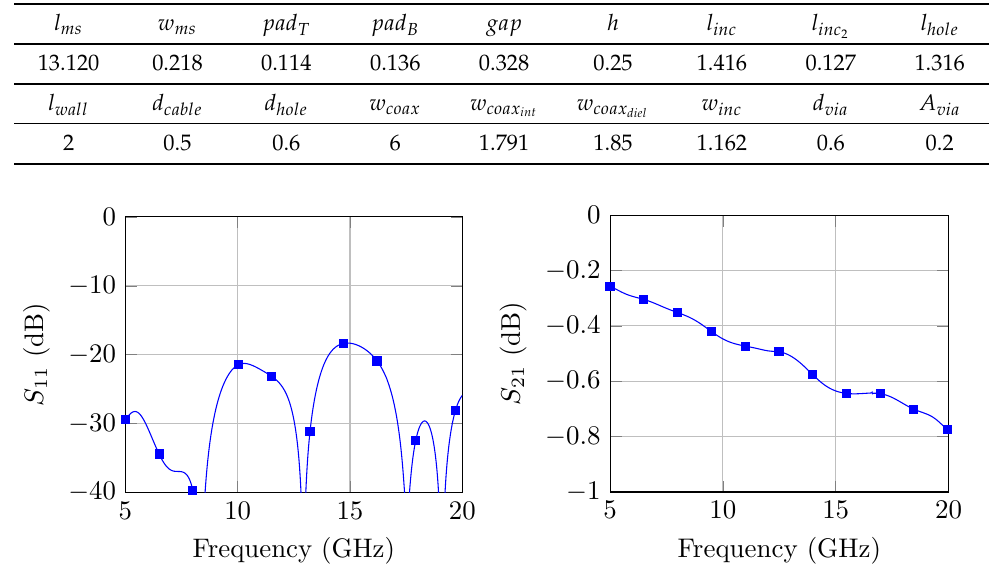
Figure 3. Results of the simulated scattering parameters for the back-to-back prototype combining Taconic-RF (microstrip layer) and Rogers 4003C (rest). Table 2. Values of the parameters (mm) for the second design of the through-wire ESICL transition (all the layers manufactured with Rogers 4003C).